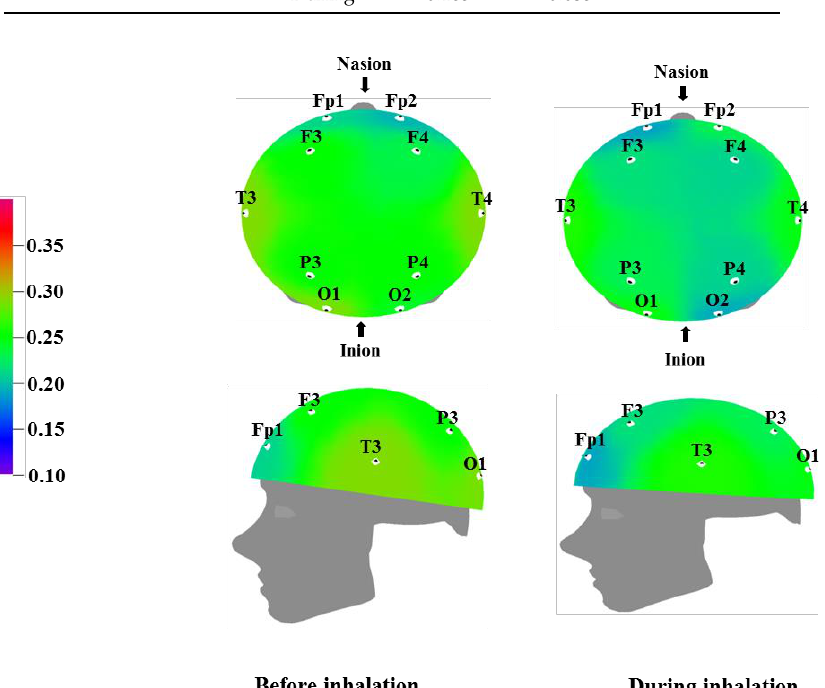
Figure 3. Relative beta wave intensity between before and during inhalation of VOCs from C. indicum Linné.